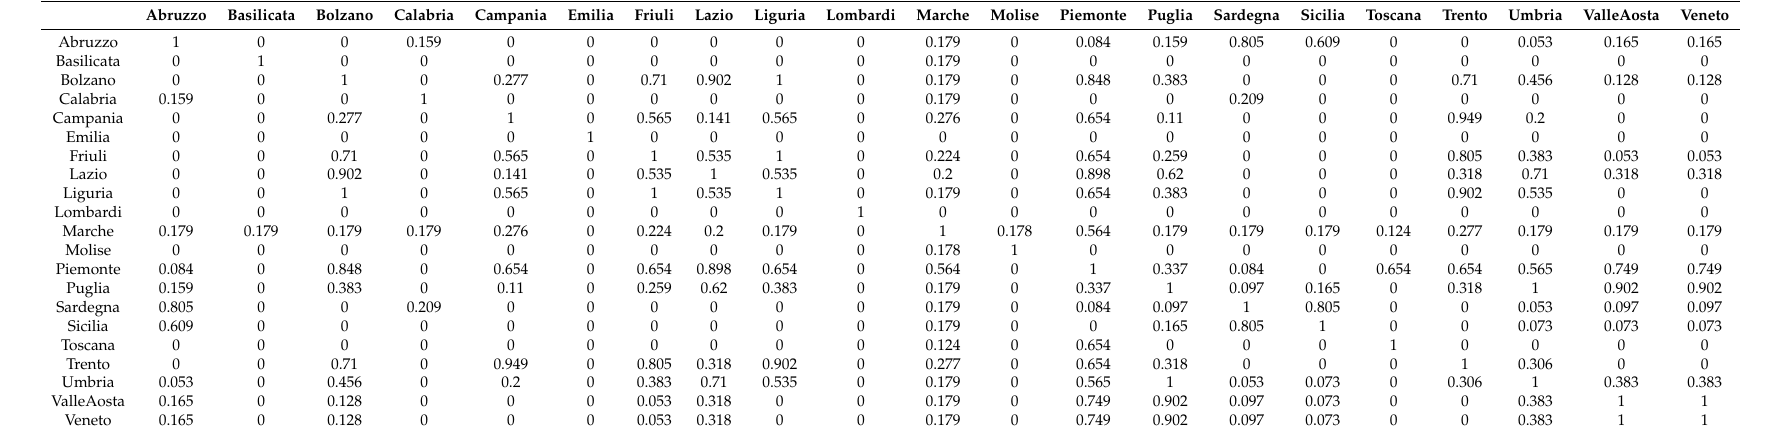
Table A23. Similarity values of Home Isolation network in the fourth week.